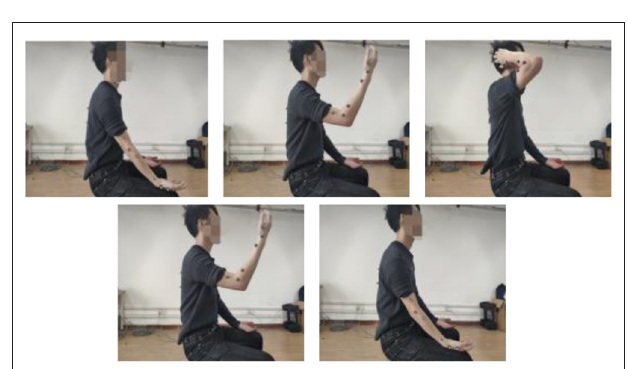
FIGURE 3 | Coordinated training, Task 2: touching